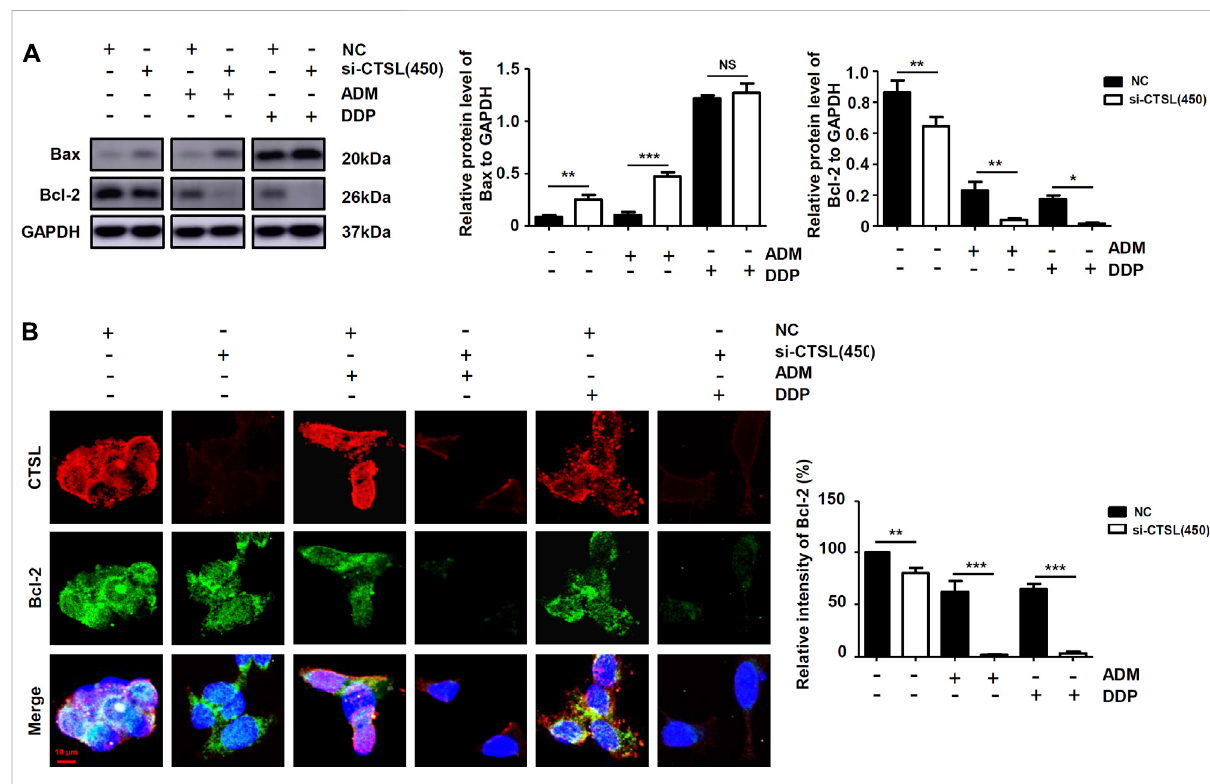
FIGURE 5 The apoptosis level of NB cells after knockdown of CTSL (A) Western blot showing apoptosis proteins expression in SK-N-BE (2) cells with differenttreatments (B) Immuno fl uorescenceassayshowingtheexpressionandintracellularlocationofCTSLandBcl-2inSK-N-BE(2)cells(redbar: 10 μ m). NS: not statistically signi fi cant, *, p < 0.05, **, p < 0.01, ***, p <